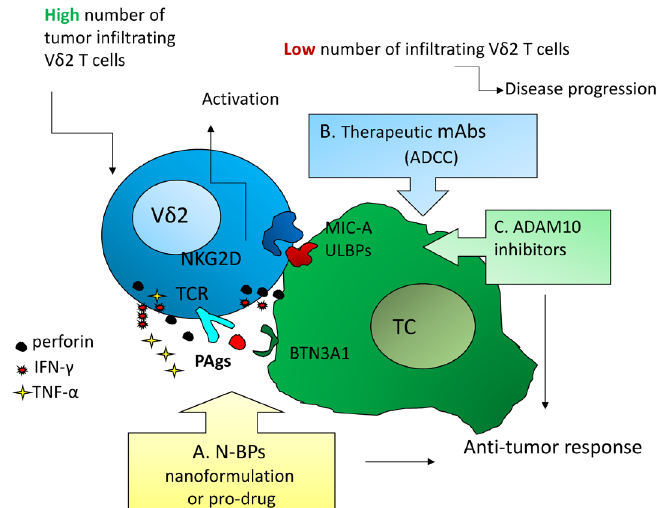
Figure 1. Activation mechanisms as possible points of therapeutic intervention to trigger anti-tumor γδ T effector cells. A: N-BPs, either soluble or nanoformulated or as pro-drugs, to induce PAgs accumulation, BTN3A1/2 conformational changes, and T cell receptor-mediated activation of Vδ2 T cells [10 – 13]; B: therapeutic mAbs to trigger γδ T cell-mediated ADCC [1, 2]; C: a disintegrin and metalloproteinase 10 (ADAM10) inhibitors to up-regulated “stress-inducible” molecules and activate γδ T cells through the NKG2D receptor [ 6 , 14]. These approaches should be efficient mainly when a high number of γδ T cells, mainly the Vδ2 subset that recognizes PAgs [2, 3], infiltrate the tumor. BTN3A: butyrophilin 3A; TC: tumor cell; TCR: T cell